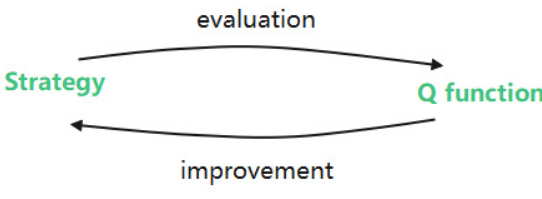
Figure 9. Schematic diagram of algorithm iteration.